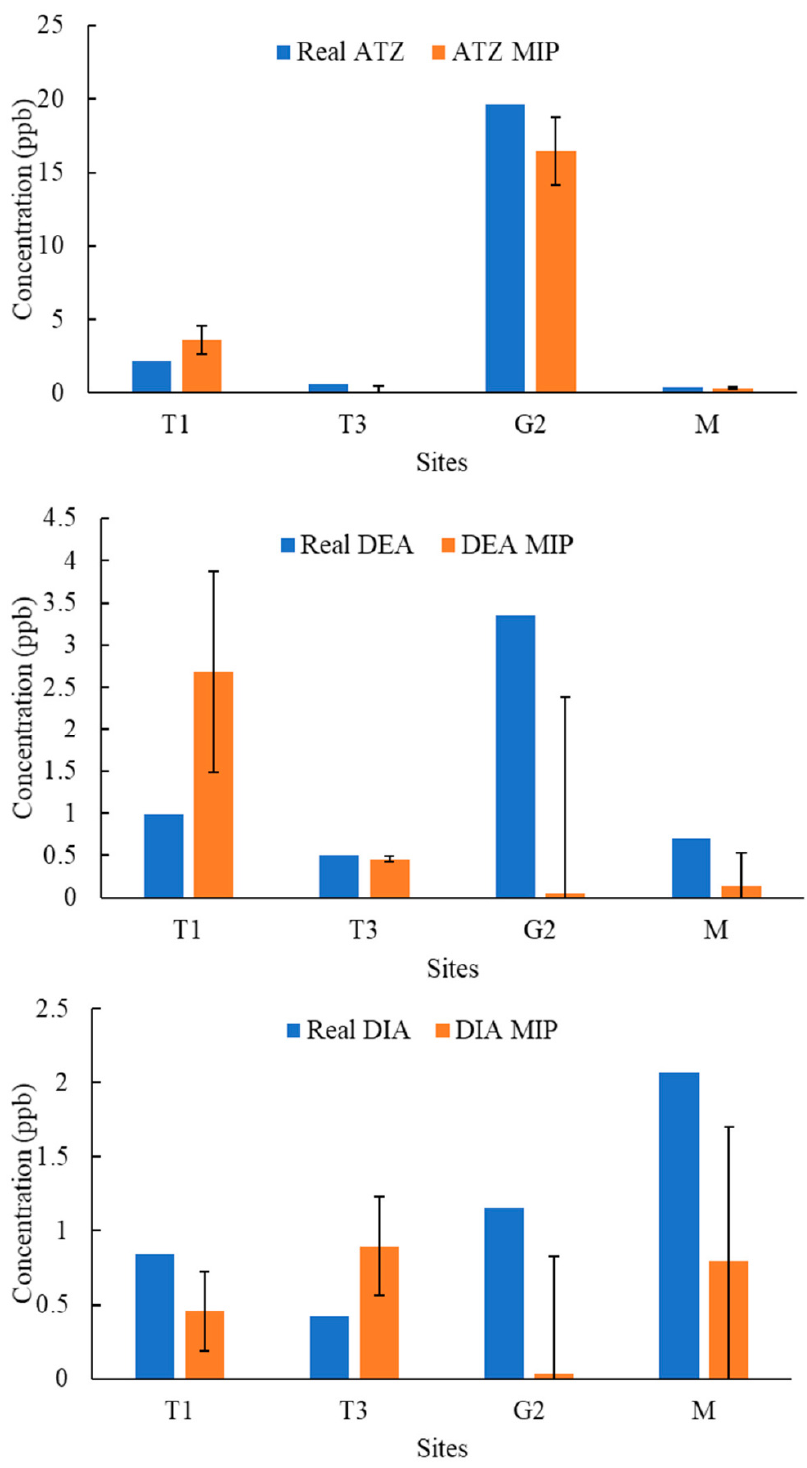
Figure 8. Average response of MIPs to ATZ, DEA, and DIA compared to real concentrations validated by LCMS/MS for samples of 23 October 2020.